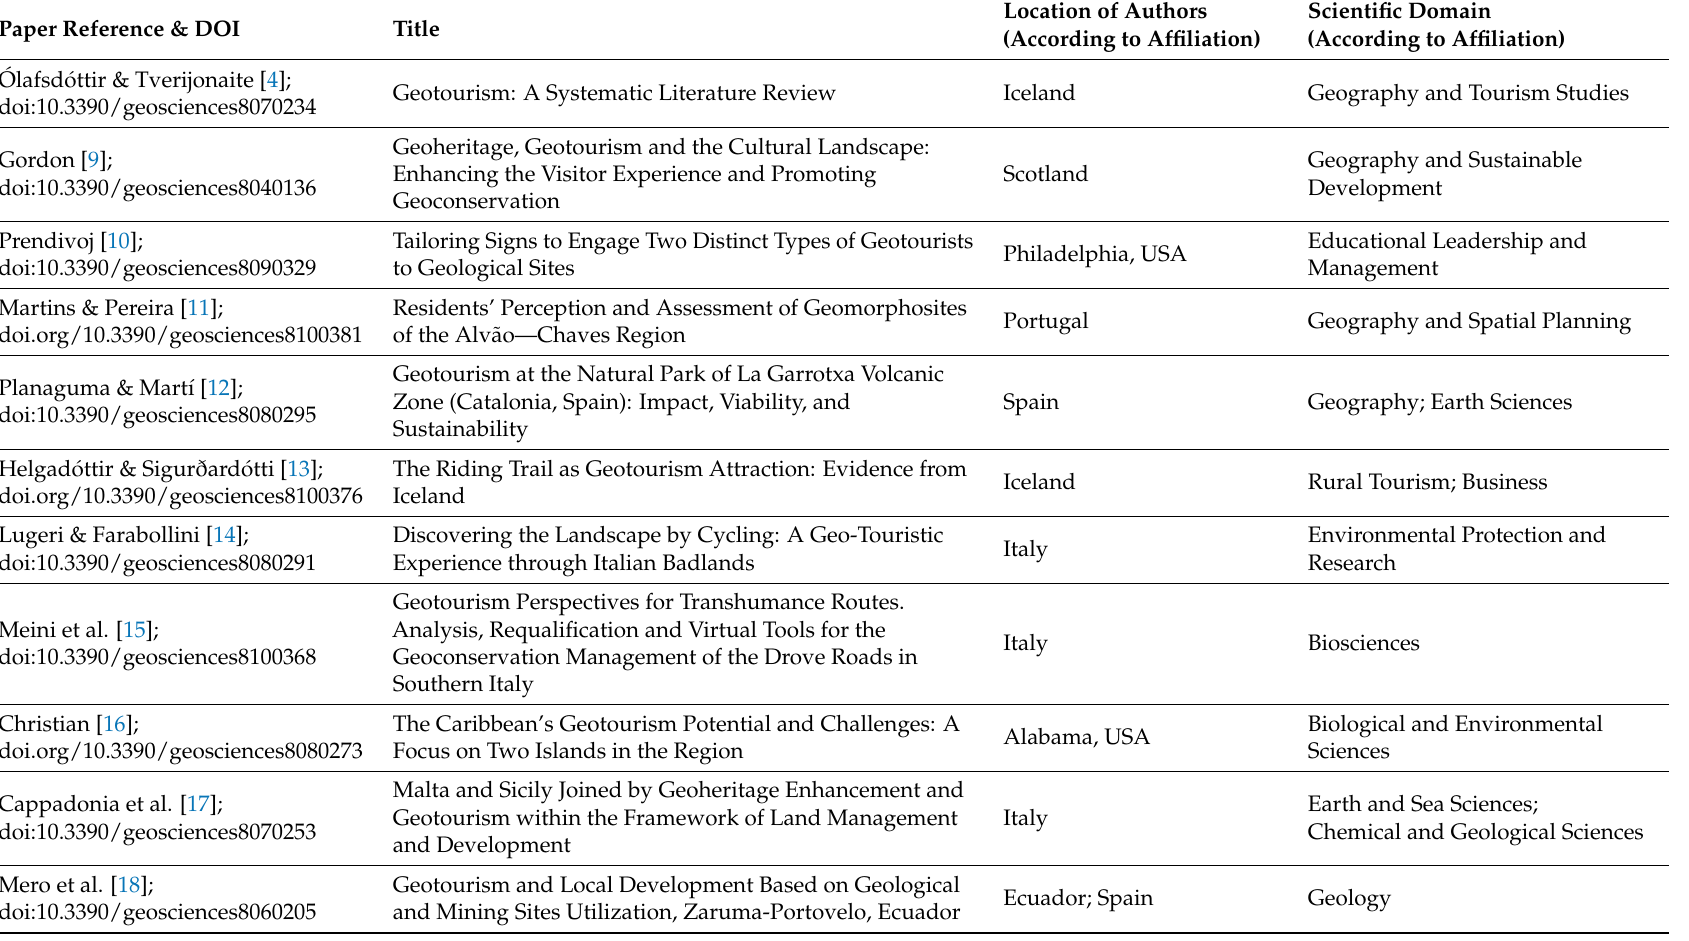
Table 1. Papers presented in the “Geotourism” Special Issue of Geosciences